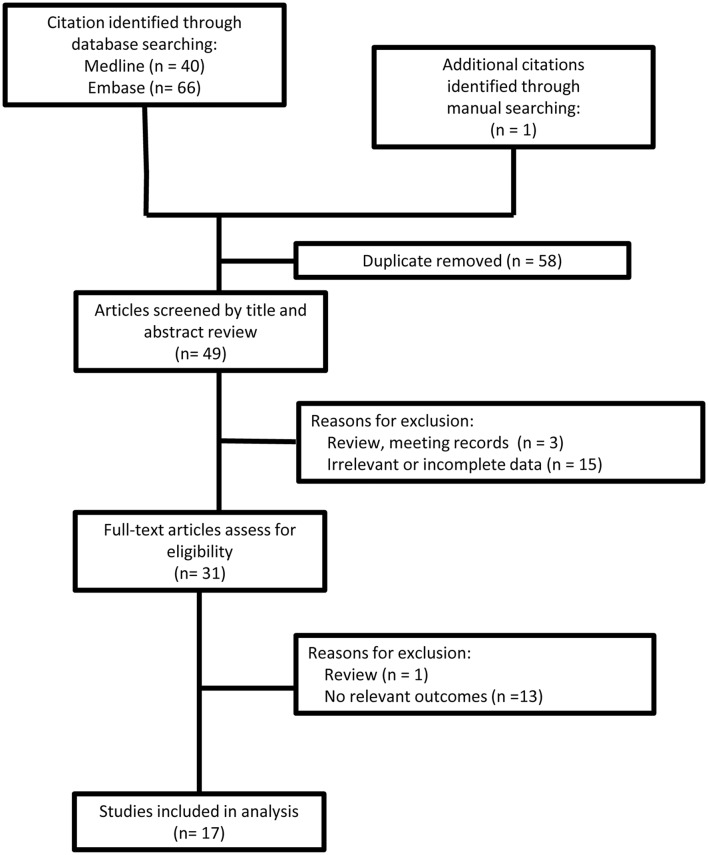
Flowchart of search strategy and study selection.